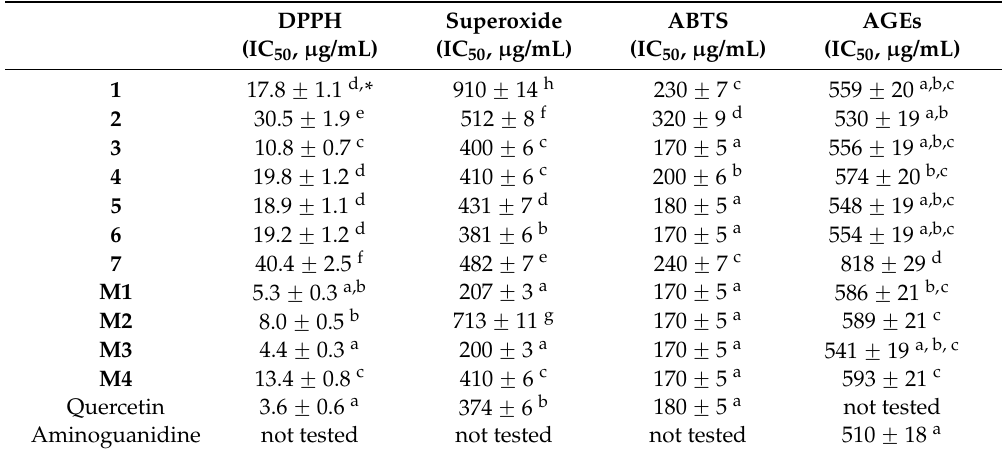
Table 6. DPPH, superoxide, total antioxidant activity (ABTS) scavenging, and advanced glycation endproducts (AGEs) inhibitory activity of compounds 1 – 7 (IC 50